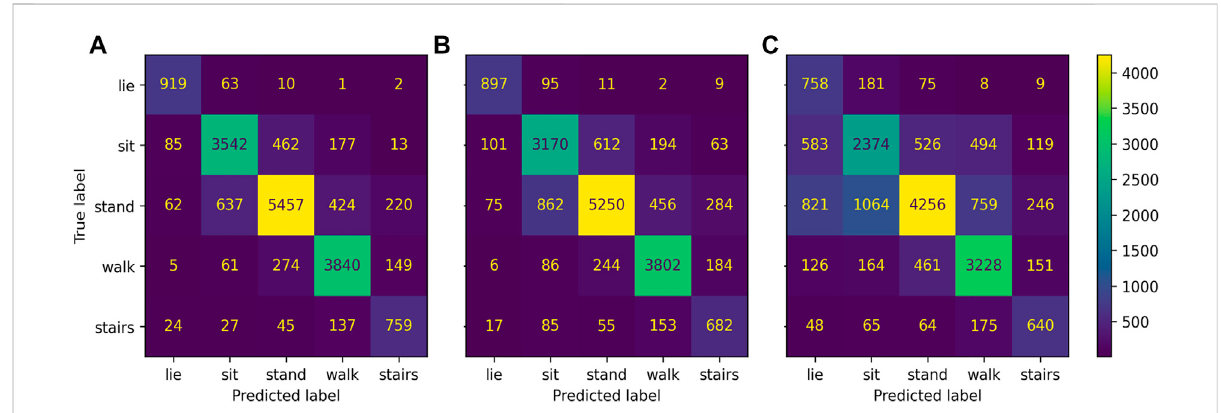
FIGURE 7 Confusion matrix Gait and Posture classi fi cation task for the three district sensor setups: bilateral setup all sensors, (A) , unilateral setup (non- affected ankle and wrist sensor, (B) , wrists-only setup (C) .